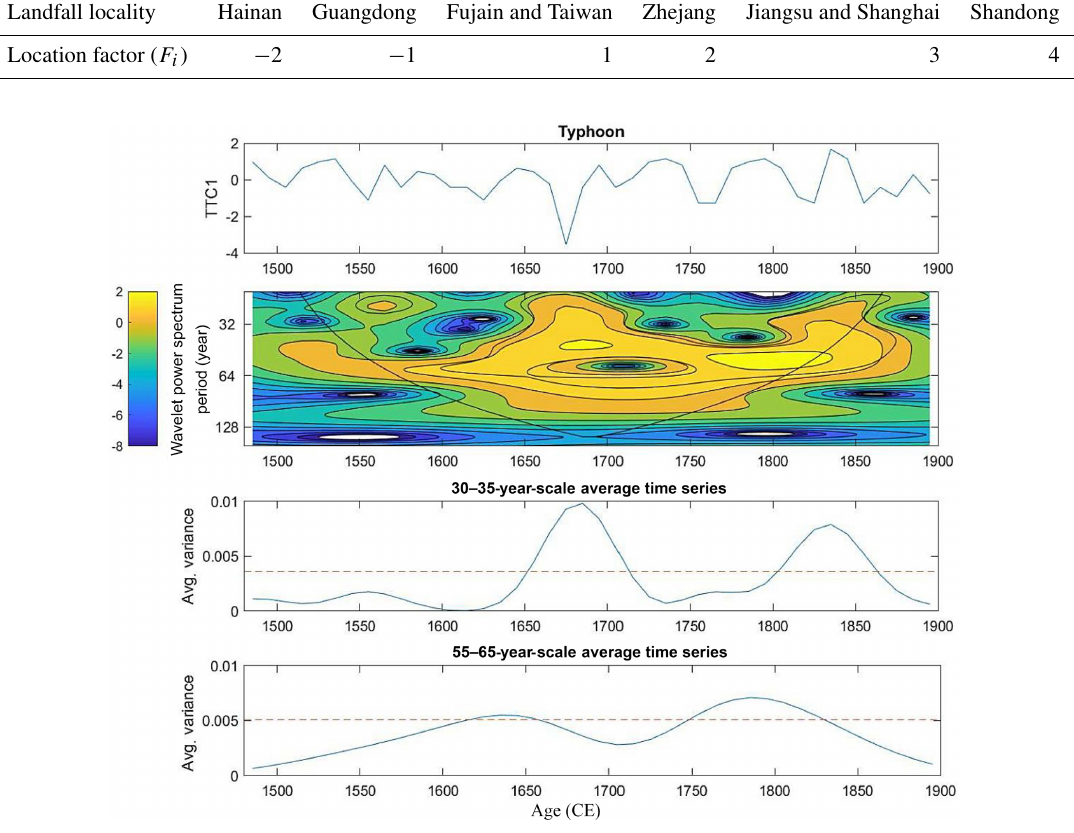
Figure 9. The wavelet analysis of the TTC1 during the